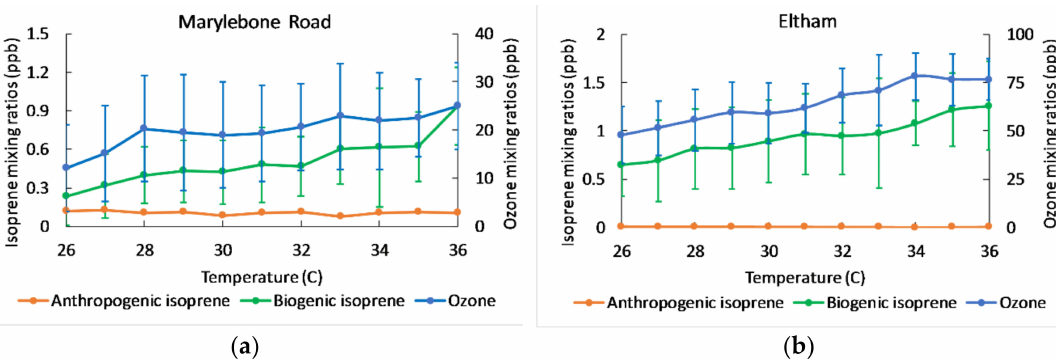
Figure 5. The mixing ratios of ozone, biogenic and anthropogenic isoprene with the variation of temperature from 26–36 ◦ C for London urban areas ( a ) Marylebone Road, ( b )